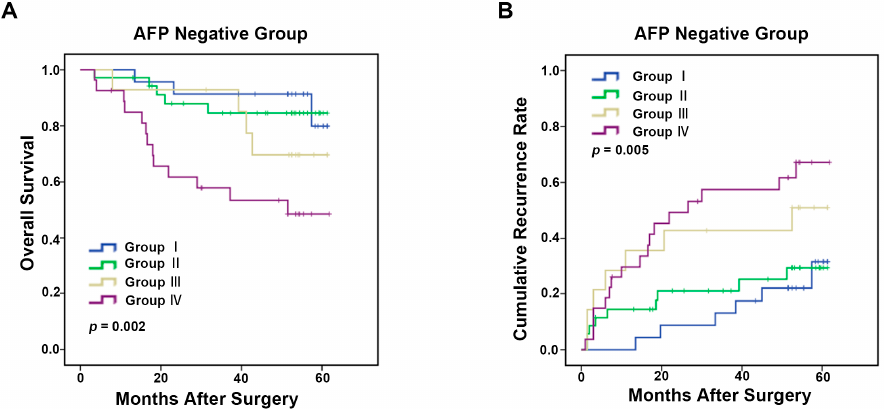
Figure 5. Kaplan–Meier curves for overall survival ( A ) and time to recurrence ( B ) of HCC patients with negative α -fetoprotein (AFP) (AFP ≤ 20 ng/mL) based on the CD86 + /CD206 + TAMs predictive model in the cohort ( n = 99).